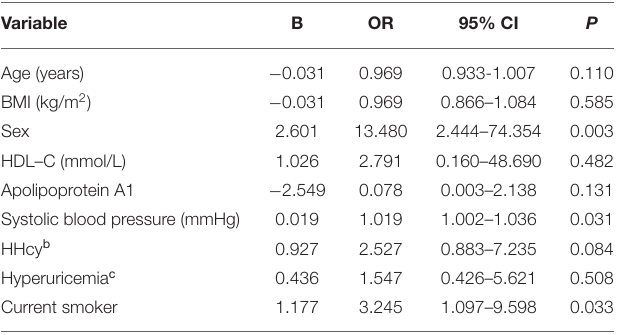
TABLE 4 | Multivariate analysis identified factors related to intracranial T 1 hyperintensity a . Variable